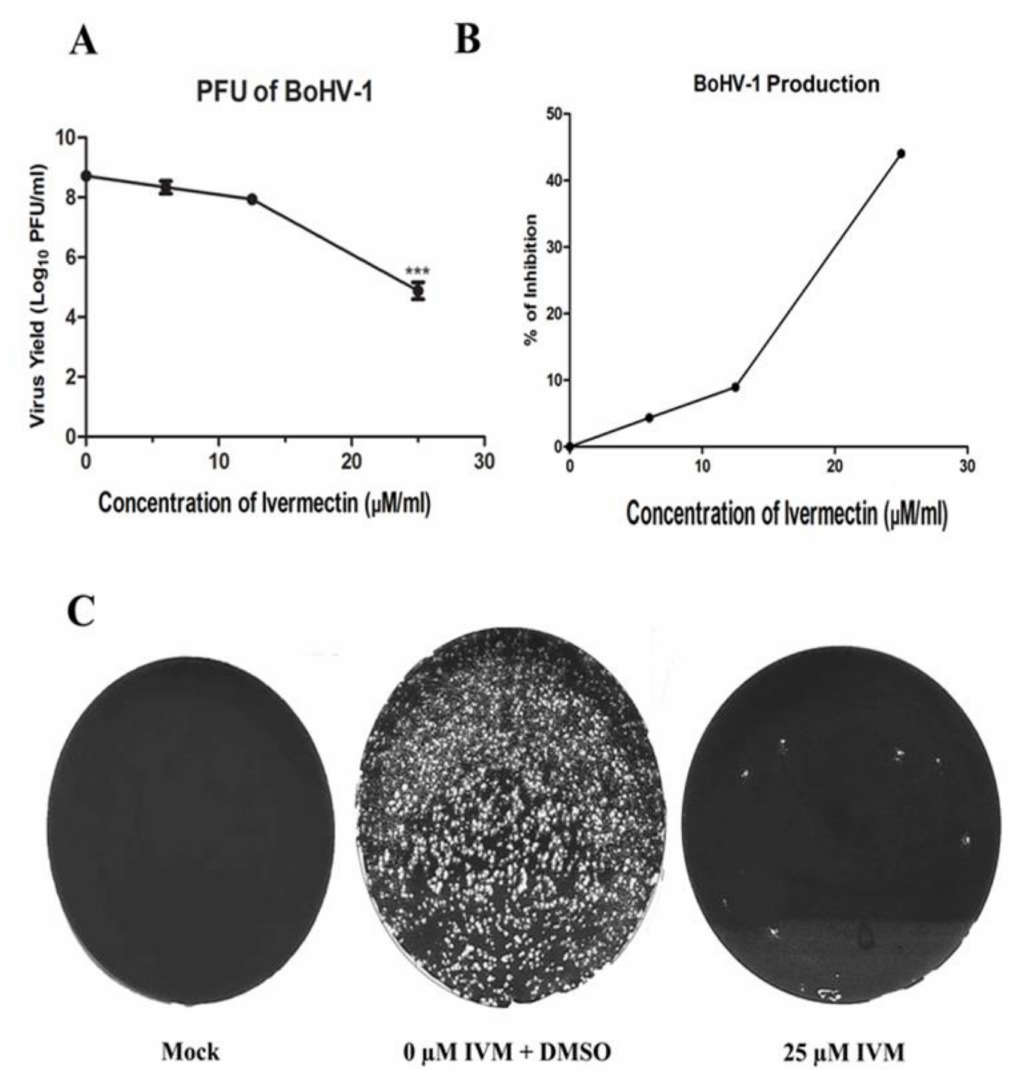
Figure 4. IVM impairs BoHV-1 replication. ( A ) MDBK cells were infected with BoHV-1 at MOI